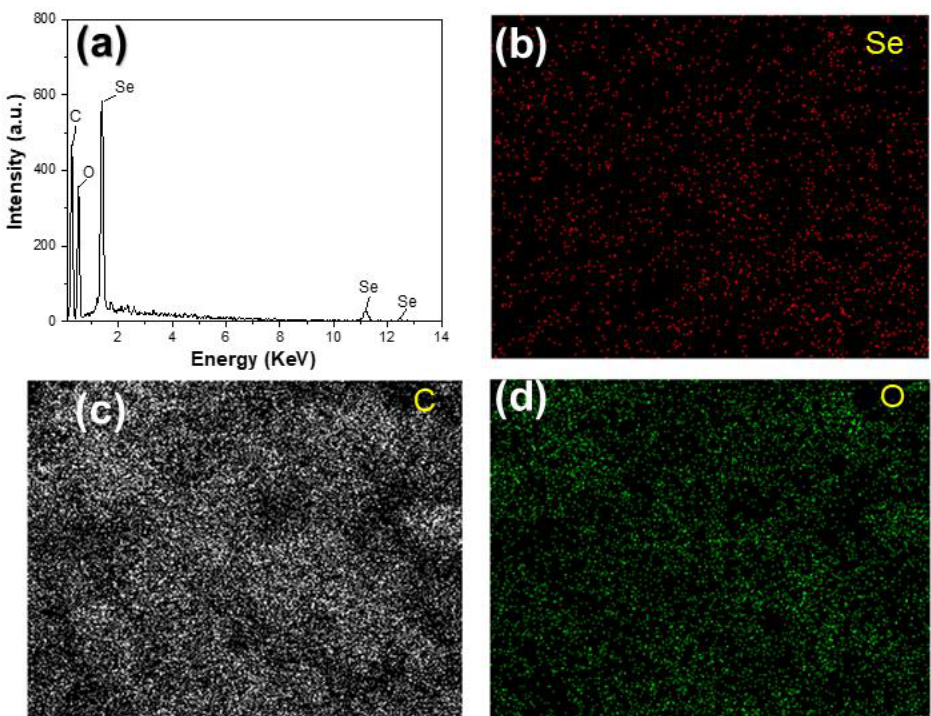
Figure 5. ( a ) EDS spectrum and EDX mapping ( b – d ) of the Se NPs prepared with the Se 4+ /CO volume ratio of 1/2.